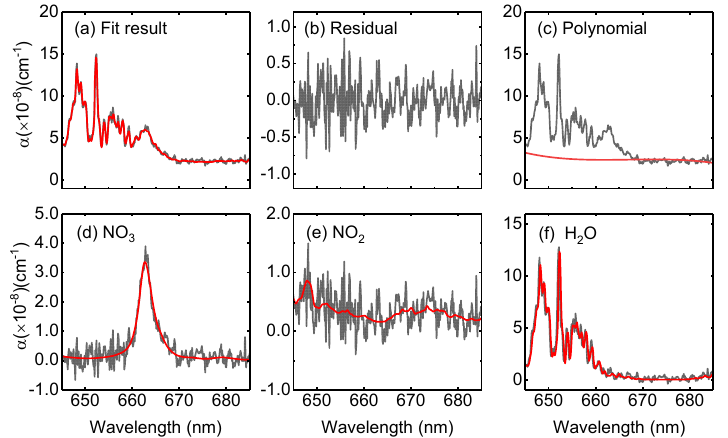
Figure 8. One spectrum fitting example of chamber experiment with a 2 s integration time. The black and red line are the measured and fitted data, respectively. ( a ) fit result, ( b ) Residual, ( c ) Polynomial, ( d ) NO 3 , ( e ) NO 2 , and ( f ) H 2 O, respectively. The retrieved mixing ratios of NO 3 , NO 2 and H 2 O are respectively 55.6 ± 2.5 pptv, 11.5 ± 2.8 ppbv, and 0.80 ± 0.02%.